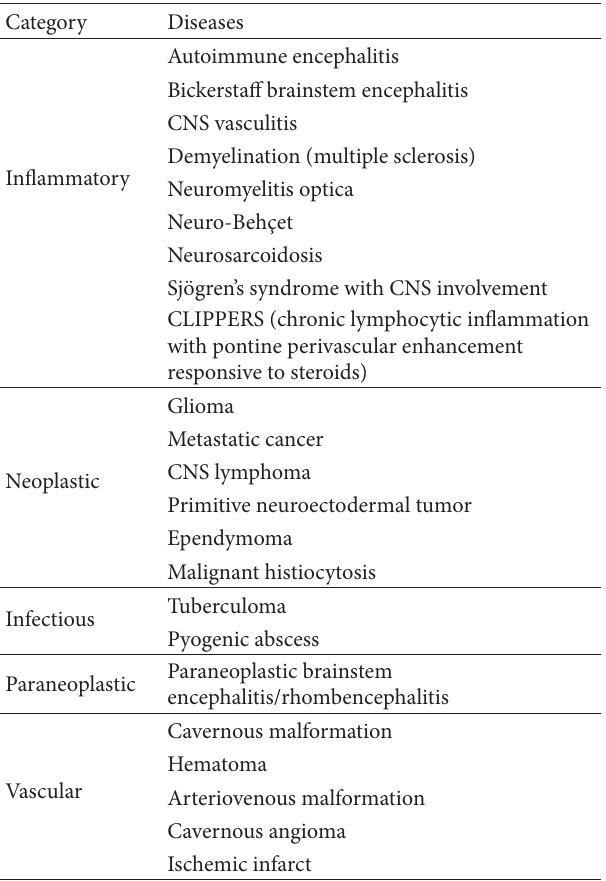
Table 1: Differential diagnosis of brainstem